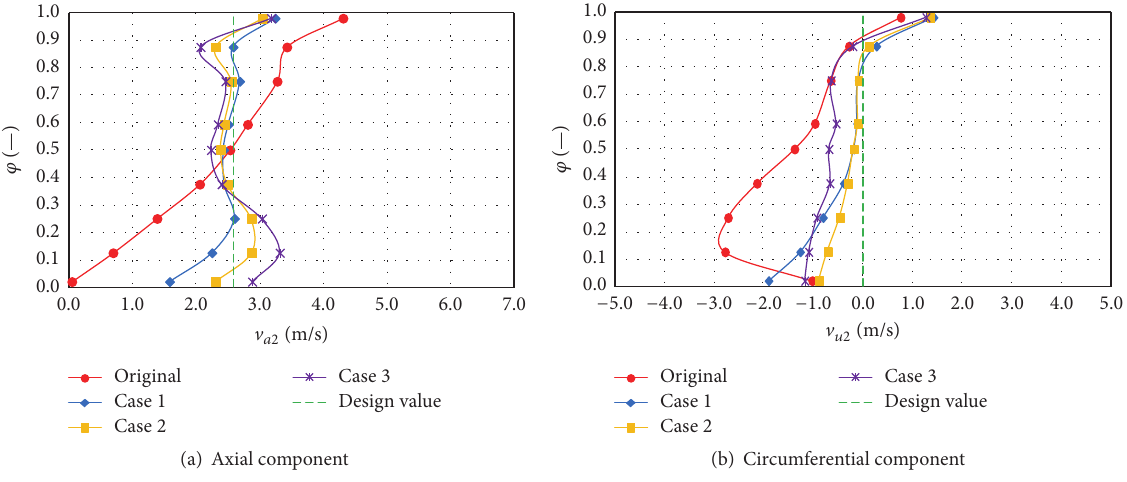
Figure 10: Absolute velocity at runner outlet ( 𝑛 = 2460 min −1 , Cal.).